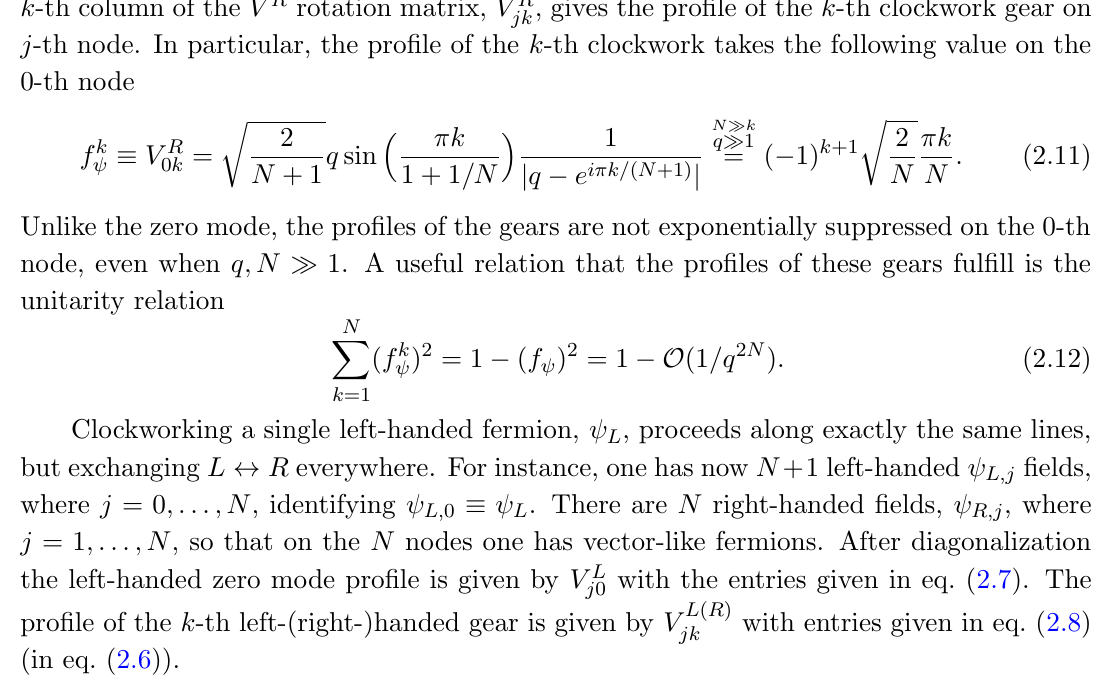
, gives the pro(cid:12)le of the k -th clockwork gear on jk